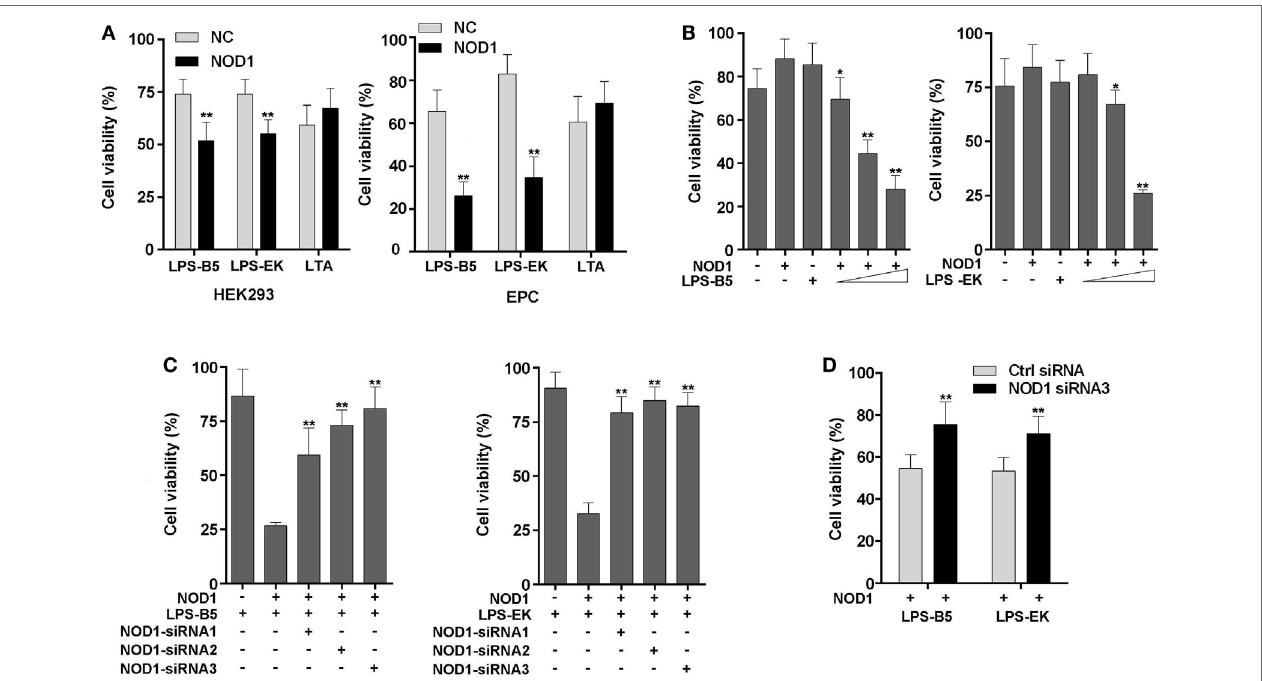
FigUre 7 | NOD1 mediates cytoplasmic lipopolysaccharide (LPS)-induced cytotoxicity in cells. (a) HEK293 and EPC cells were transfected with NOD1 expression plasmid, then stimulated the cells with LPS-B5, LPS-EK, or LTA, next after 12 h of stimulation, collect the cells to detect the cell viability. (B) NOD1 expression plasmid was transfected into HEK293 cells and stimulated the cells to perform concentration gradient test. (c) HEK293 cells were co-transfected with NOD1 expression plasmid and different NOD1-siRNAs, after 36 h of transfection, the cells were stimulated with LPS-B5 and LPS-EK, then collect the cells and detect the cell viability. (D) NOD1-siRNA3 were transfected into EPC cells that were over-expression NOD1, and then the cells were stimulated with LPS-B5 and LPS-EK, and the cell viability was detected after 12 h of stimulation. The data were expressed as mean ± SE. The statistically significant differences were indicated by asterisks (* P < 0.05 and ** P <